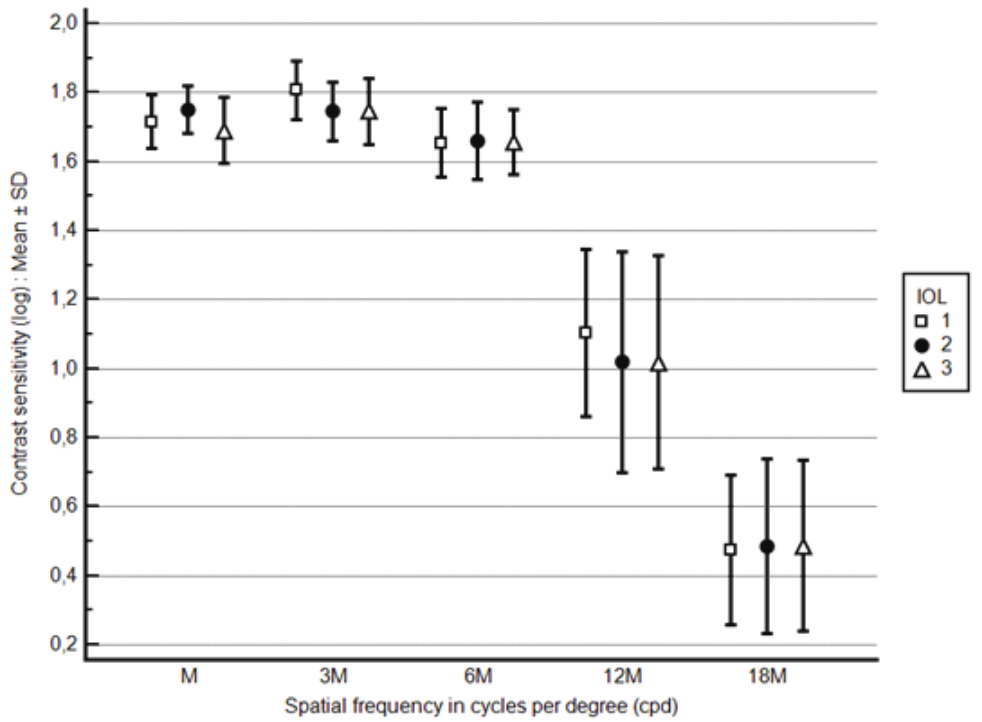
Figure 2. Postoperative contrast sensitivity (log) under mesopic conditions (3 cd/m2) in various spatial frequencies for the IOLs included in the study [IOL1 = Bioline Yellow Accurate (i-medical, Germany), IOL2 = BioAcryl 60125 (Biotech, France), IOL3 = H65C/N (PhysIOL,